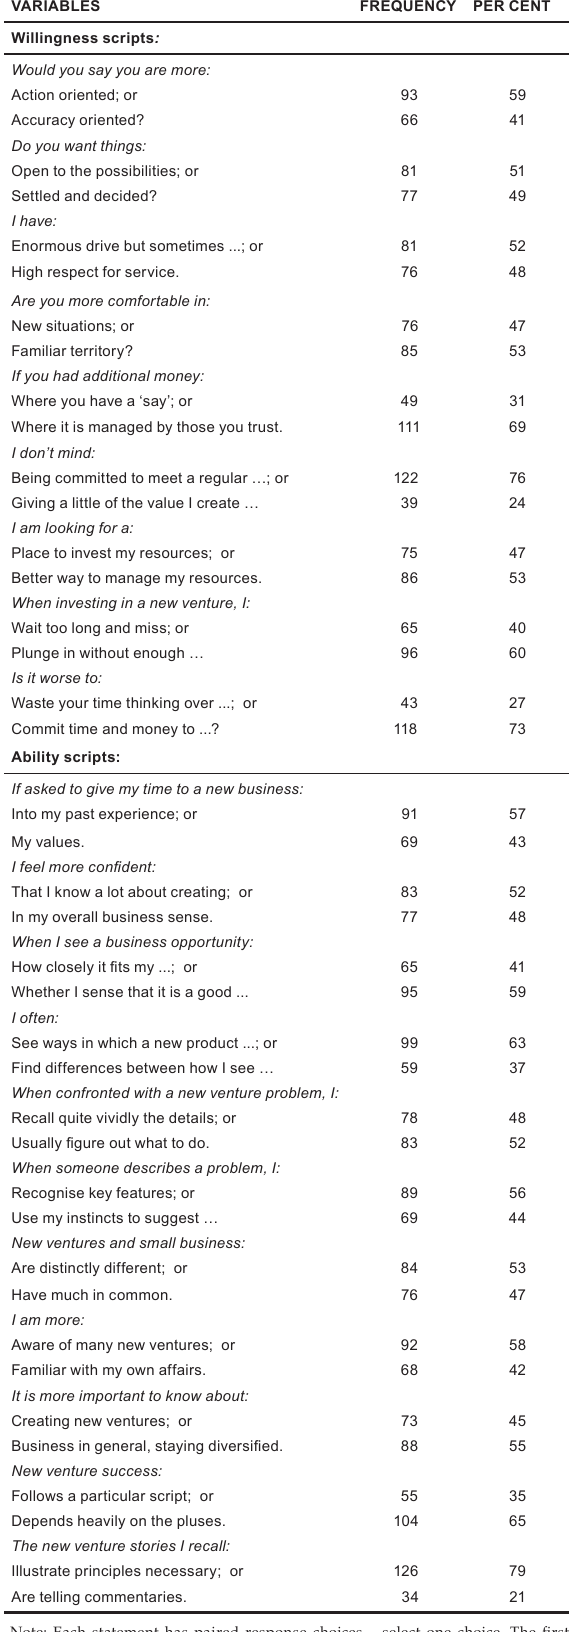
table 2 Frequencies for entrepreneurial cognitions cues: Willingness and ability